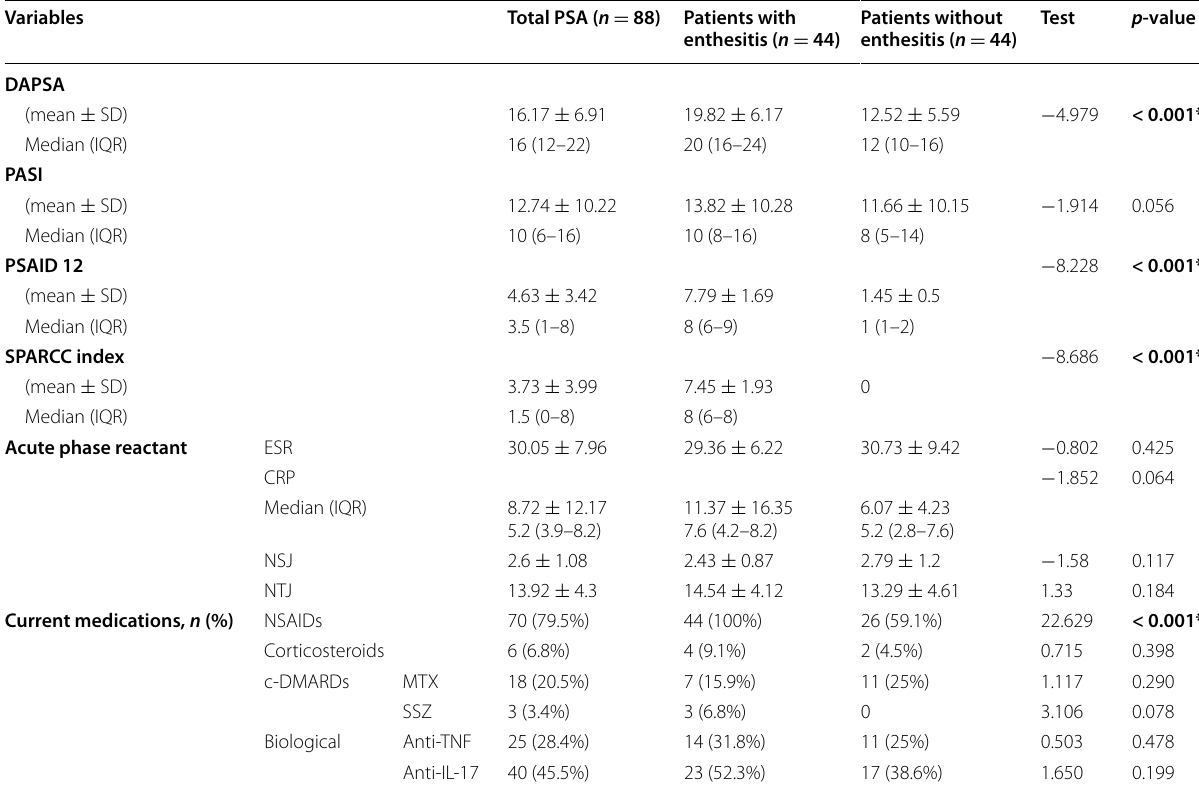
Table 2 Laboratory results and medications received by patients suffering from psoriasis-related enthesitis and those without